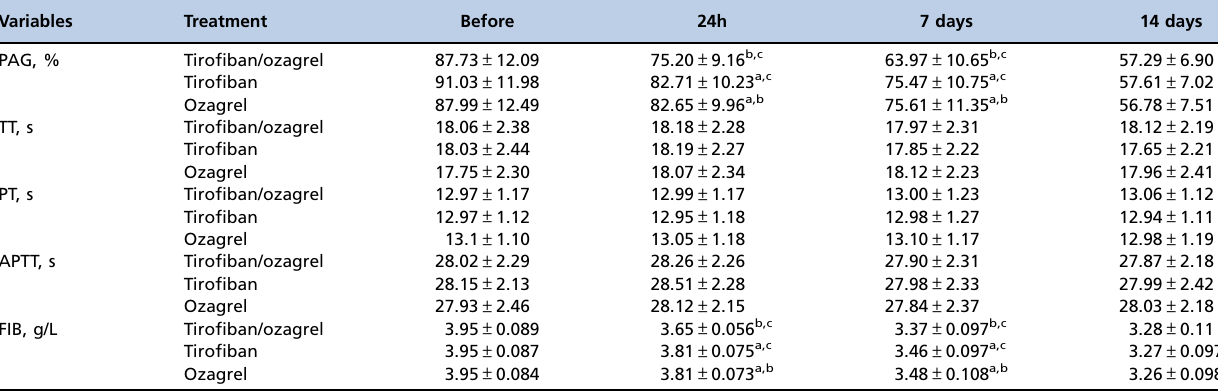
Table 2 - Changes in various thrombus-related factors in response to the various treatments. Variables